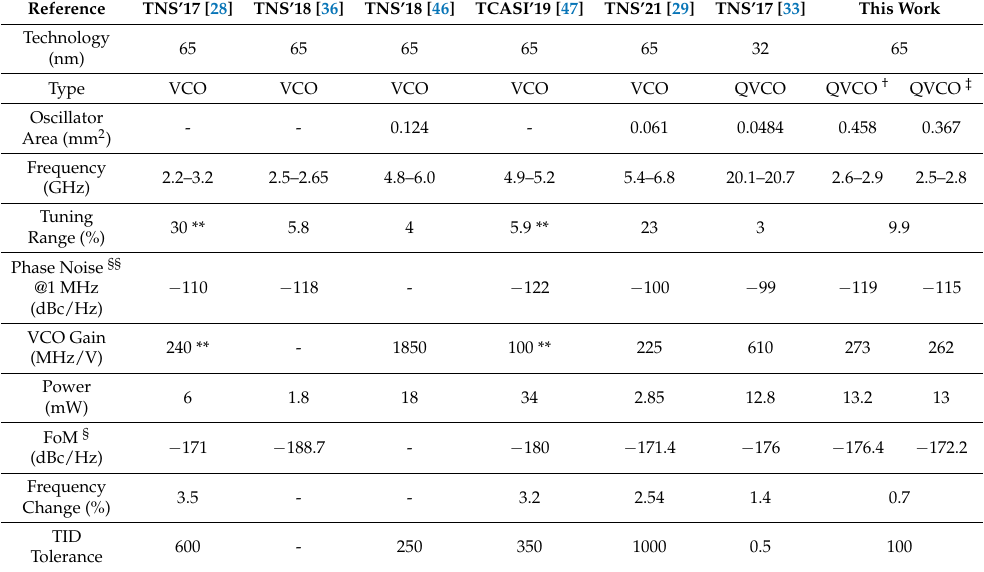
Table 1. Performance comparison with respect to previously published VCOs and QVCOs which are tested under radiation